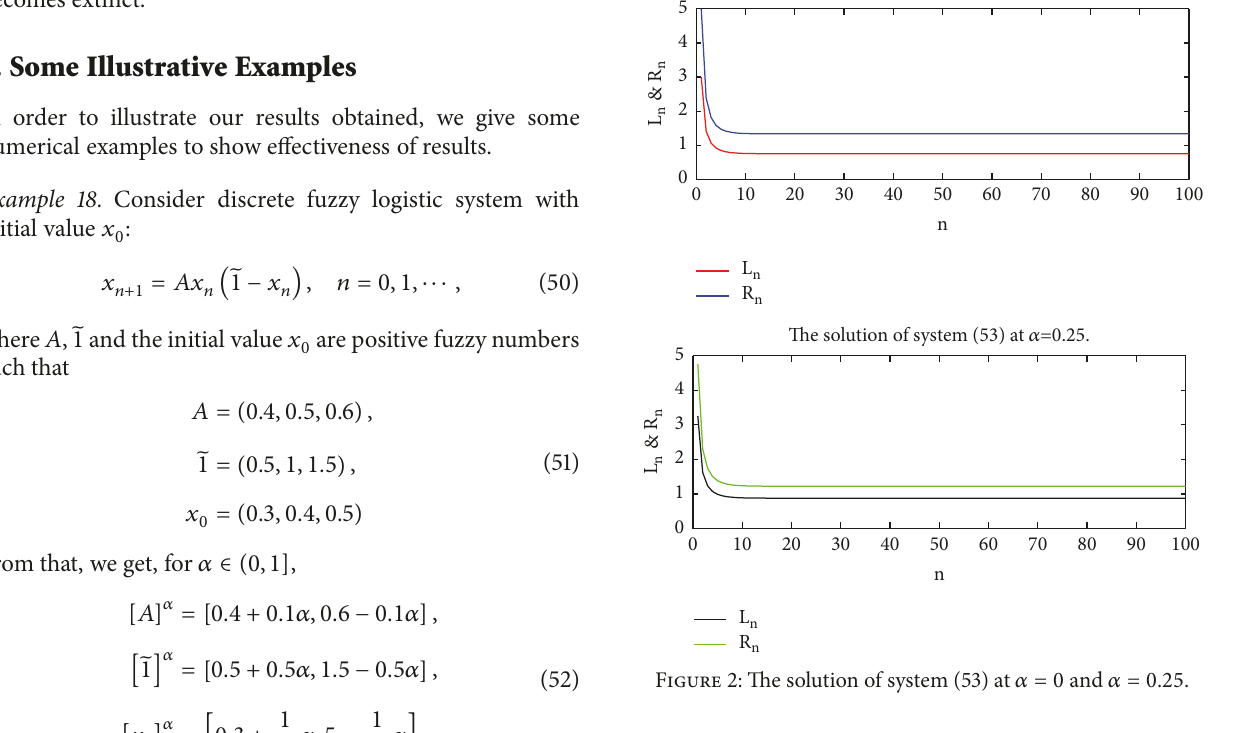
Figure 1: The dynamics of system (50) with initial value 𝑥 0 = (0.3,0.4,0.5) . The solution of system (53) at  =0